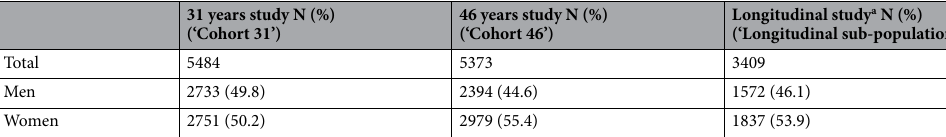
Table 1. Characteristics of the study populations. a Sub-population of those participants who had non missing SPT data on both time points (31 and 46 years).